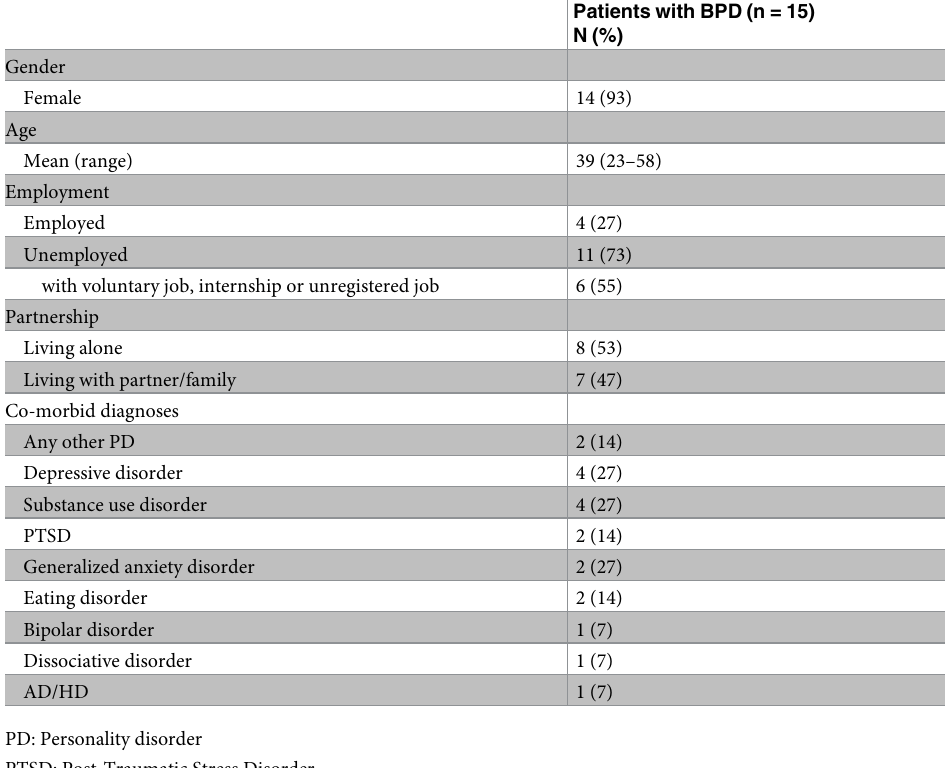
Table 1. Socio-demographic and clinical characteristics of patients with